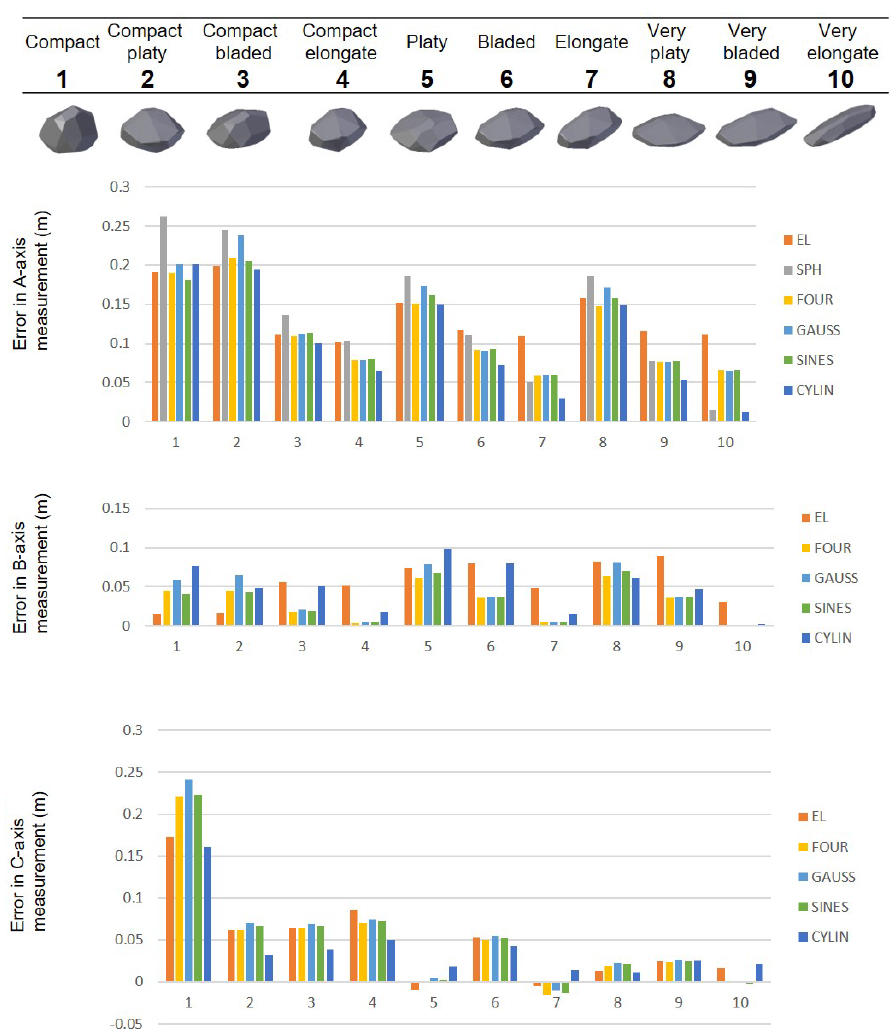
Figure 11. Error in dimension measurement for each fit compared to a set of manual measurements for the angular synthetic blocks. SPH: minimum-bounding sphere fit; EL: least-squares ellipsoidal fit; FOUR: RFSHAPZ Fourier fit; GAUSS: RFSHPZ Gaussian fit; SINES: RFSHAPZ sum of sines fit; CYLIN: RFCYLIN